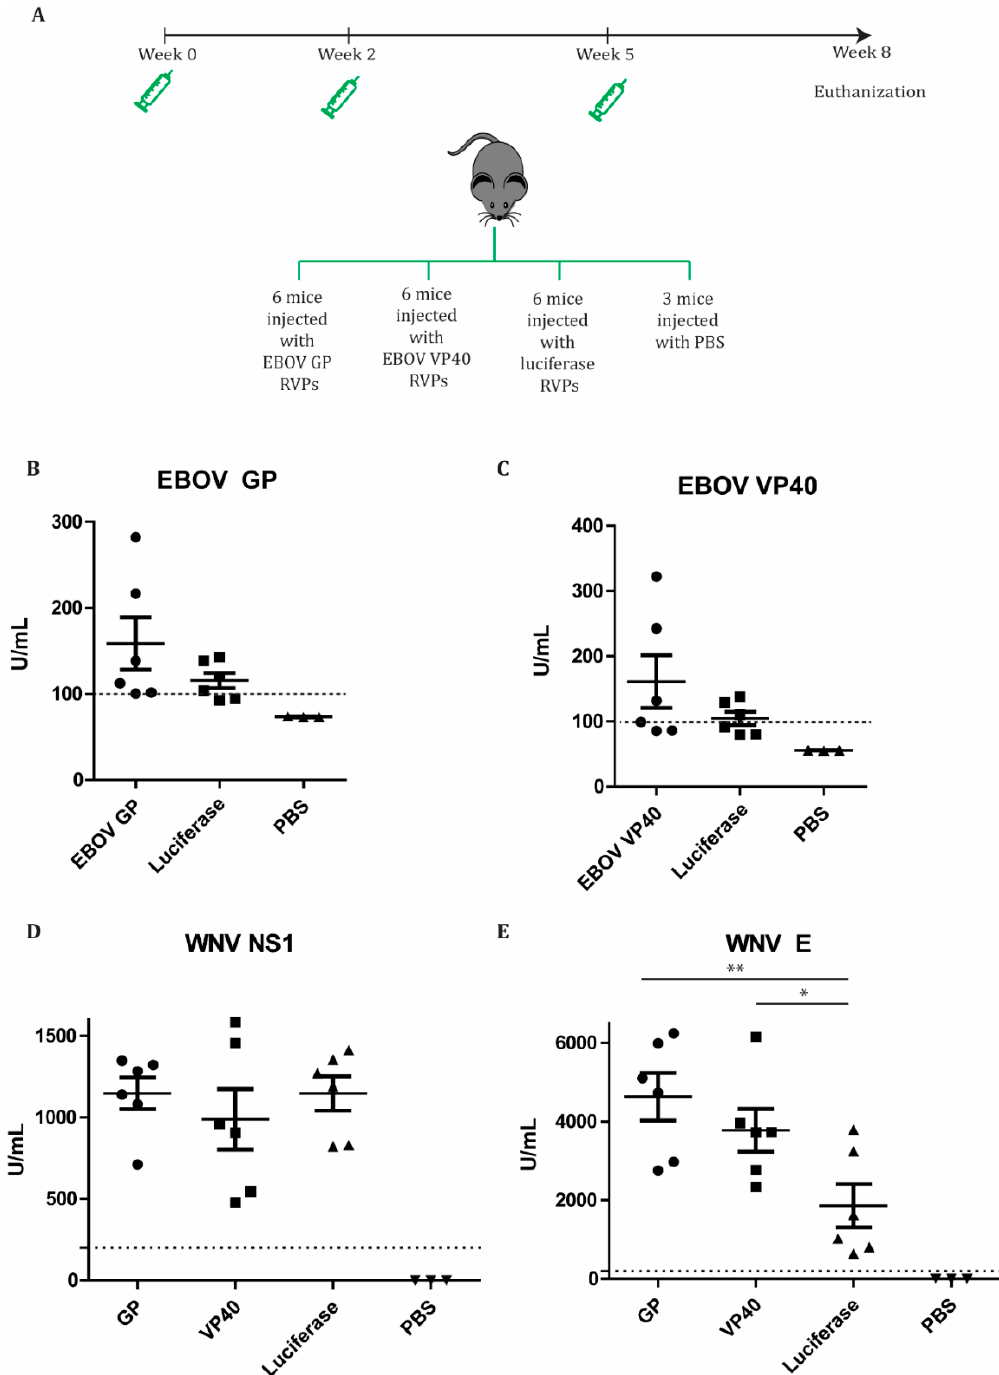
Figure 7. RVPs induced seroconversion. ( A ) Schematic illustration of the mice immunization schedule. Mice sera from the study groups were assayed with enzyme-linked immunosorbent assays (ELISA) to measure antibodies against EBOV GP ( B ), EBOV VP40 ( C ), WNV NS1 ( D ), and WNV E ( E ). The dashed line indicates the detection limit as suggested by the kit manufacturers. The assays were conducted with two technical repeats. The p values are indicated using * p < 0.05 and ** p < 0.01.